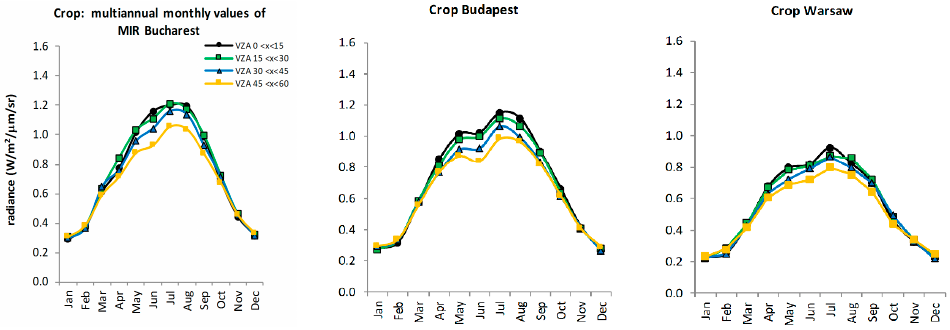
Figure 7. Mean monthly values of MIR radiance in four VZA classes for the urban cover class.